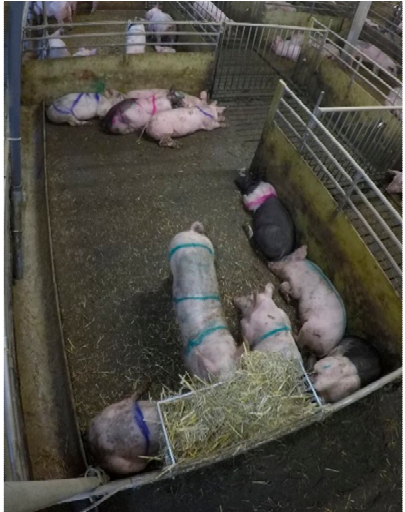
Figure 1. Pen design, including location of the straw rack.